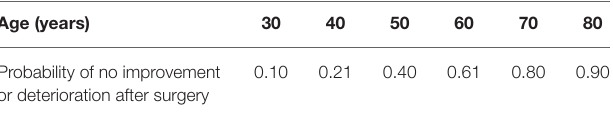
TABLE 5 | The risk of no improvement in CTS after surgery based on the logistic regression modeling of CTS severity on the Hi-Ob scale. CTS severity Probability of no improvement or deterioration after